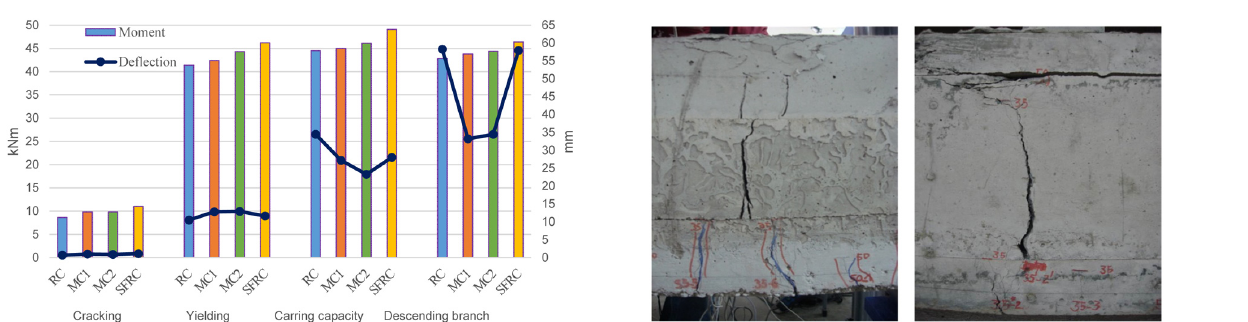
Fig. 7. Cracking layout of middle RC layers of layered beams tested